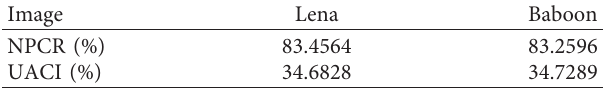
— — — Table 9: NPCR and UACI test results for the two images reported in the experiments.